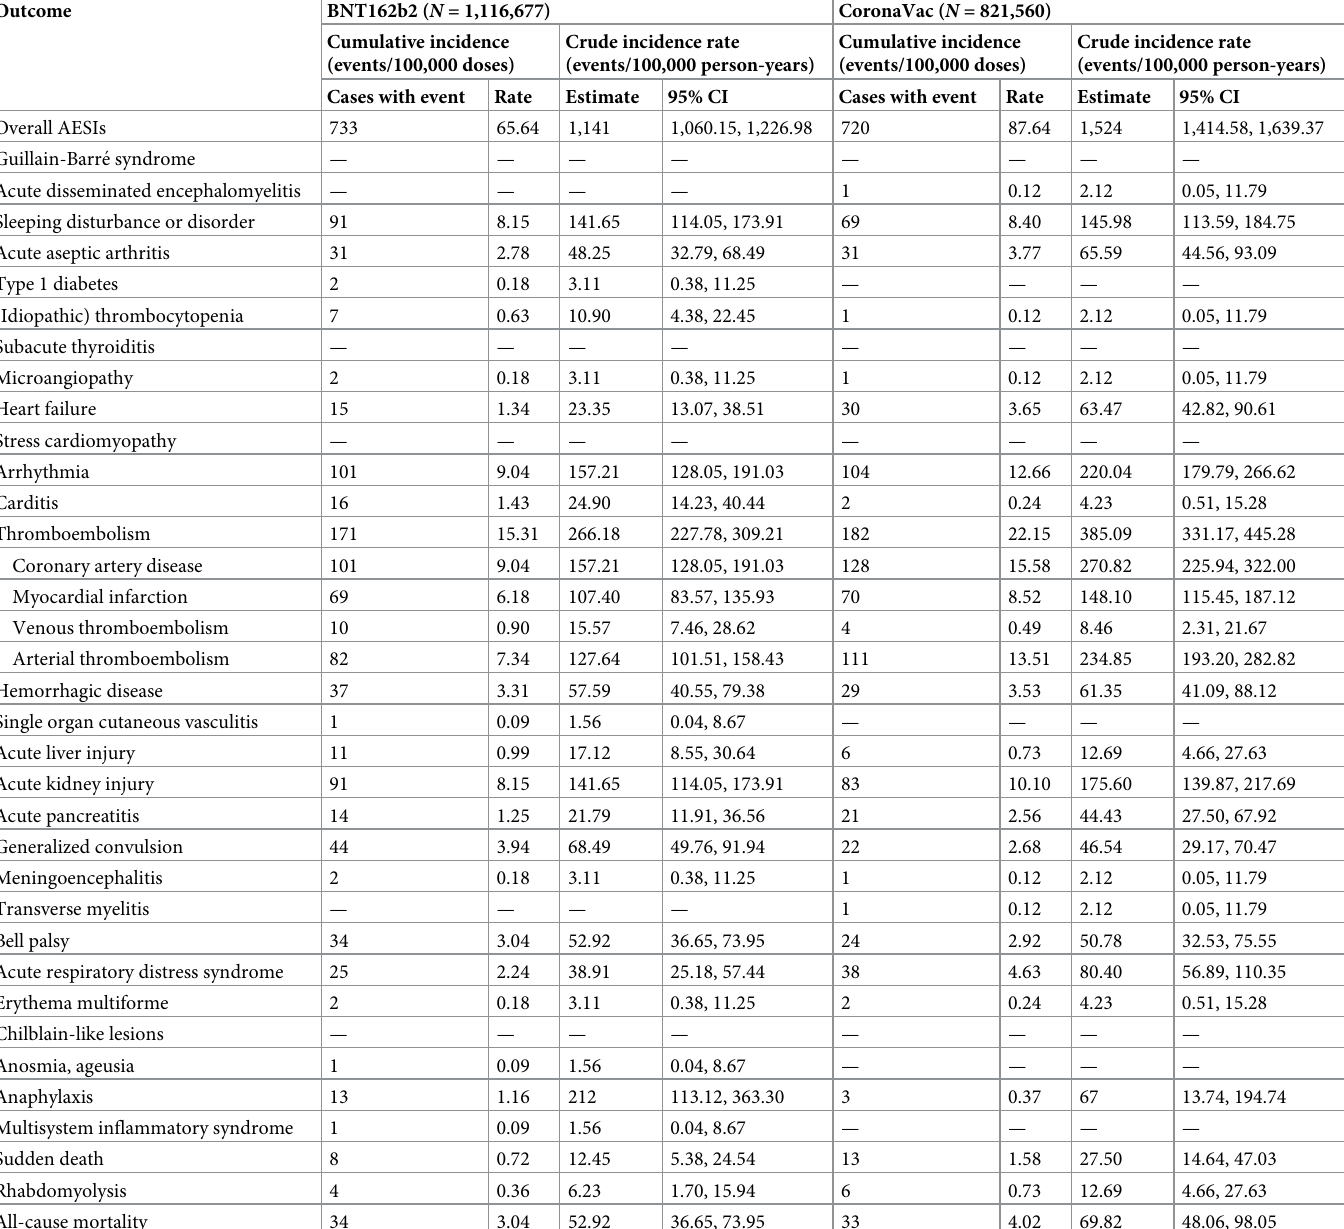
Table 4. Cumulative incidence and crude incidence rate of AESIs among second dose recipients of CoronaVac or BNT162b2 from 23 February to 9 September 2021 in Hong Kong SAR, China.